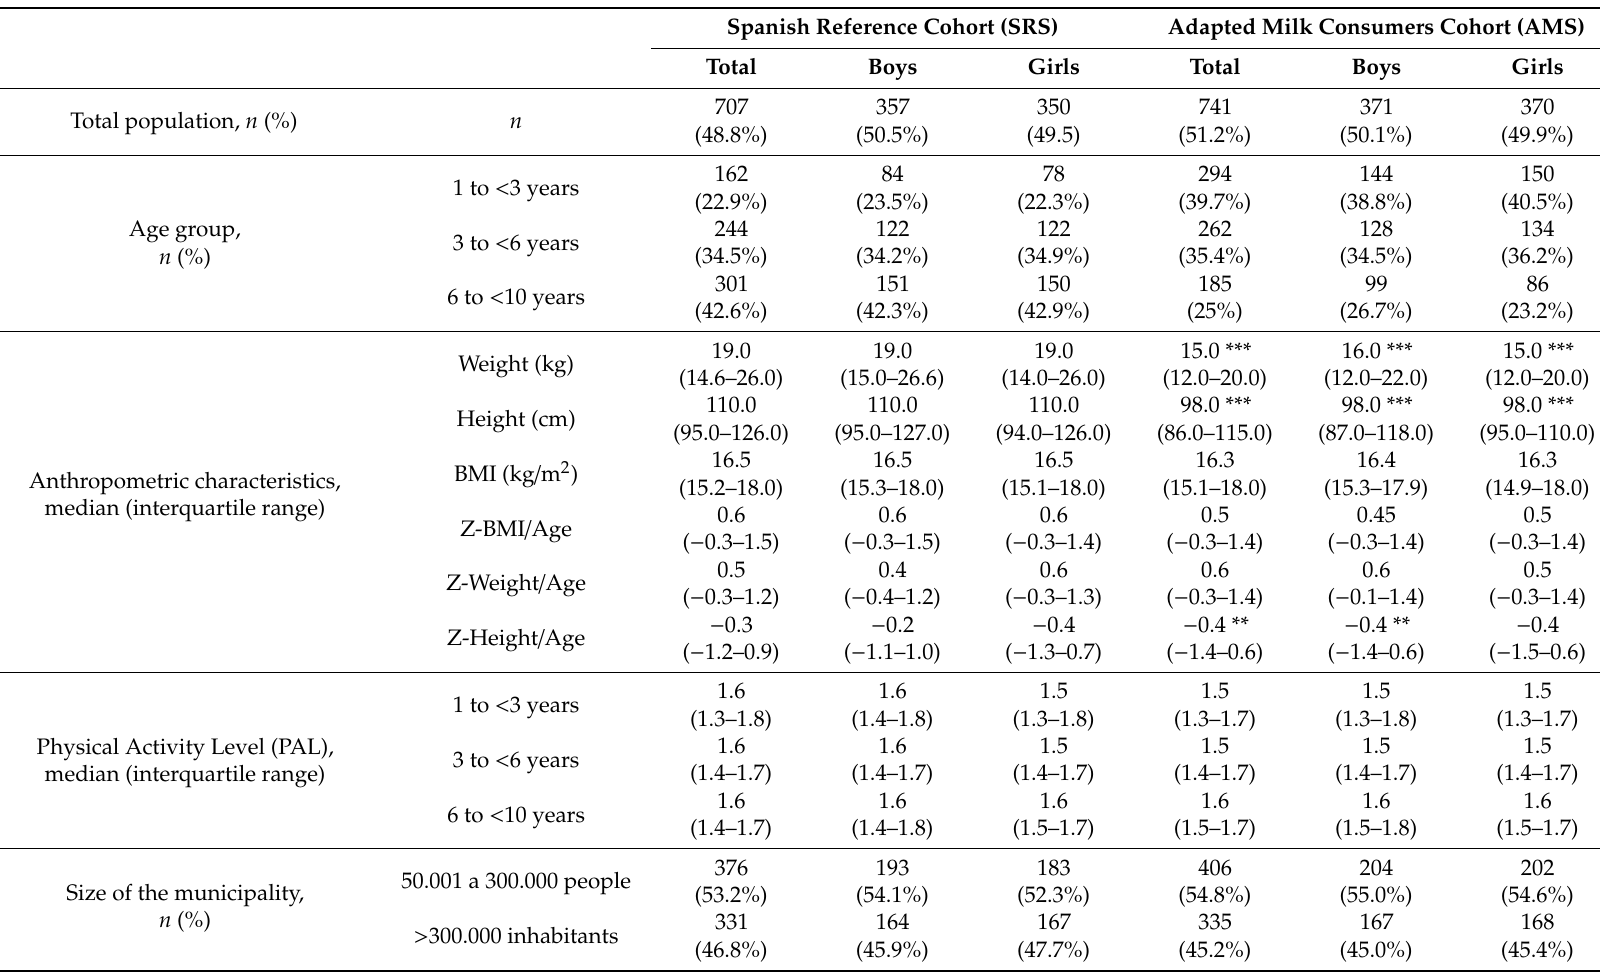
Table 1. Personal, anthropometric, and socioeconomic data by gender and age group in the Spanish Pediatric Population (EsNuPI) study. Adapted from